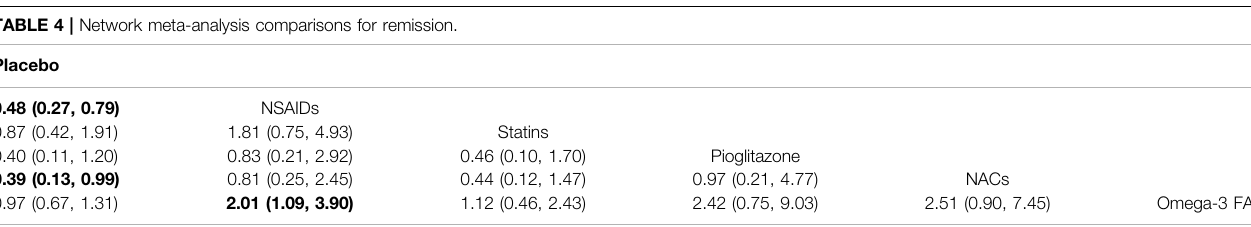
TABLE 4 | Network meta-analysis comparisons for remission. Placebo